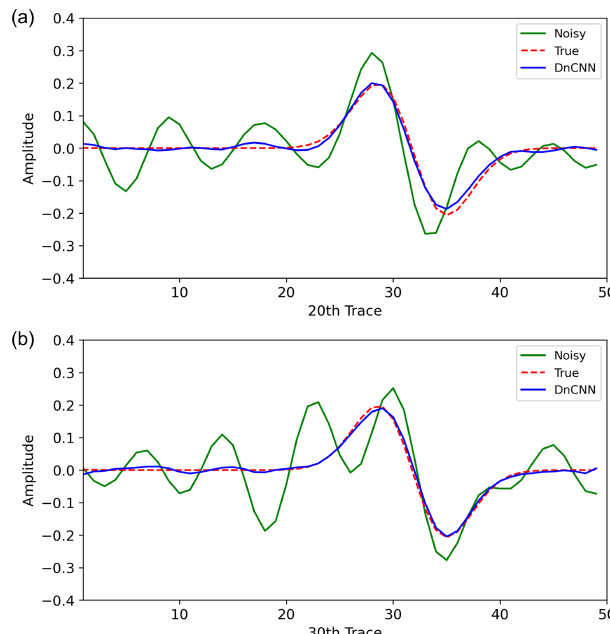
Figure 14. Comparison of the extracted traces before applying the D2 model and after applying the 40th epoch of the D2 model. The solid green line shows the trace from the noisy data, the dashed red line shows the trace from the ground truth, and the solid blue line shows the trace from the denoised data after applying the D2 model. Panel (a) shows the 20th and (b) shows the 30th vertical trace of the first test patch in Fig. 11.